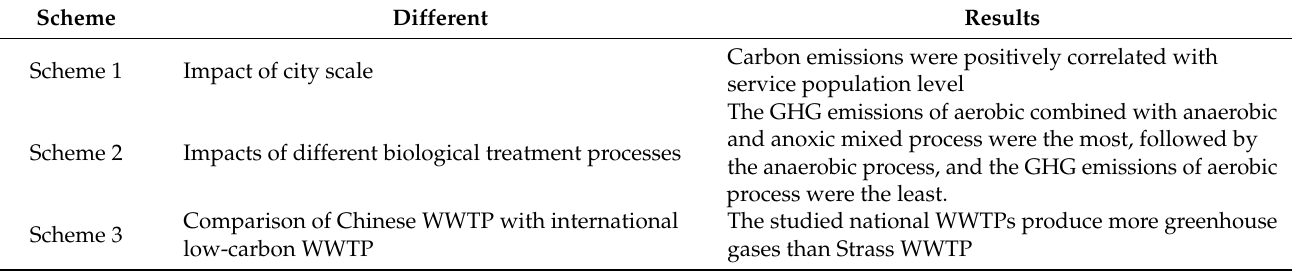
Table 1. Comparison results of the three